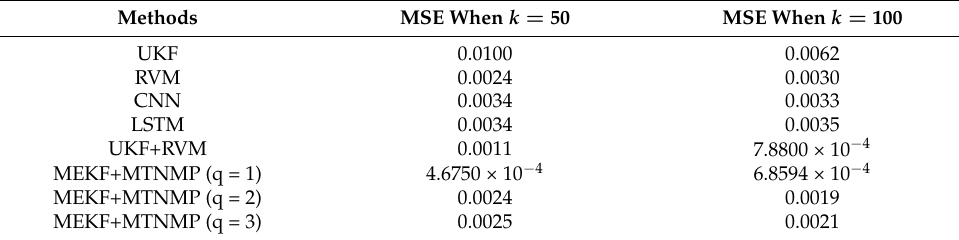
Table 6. Experimental results of the B0007 lithium-ion battery.